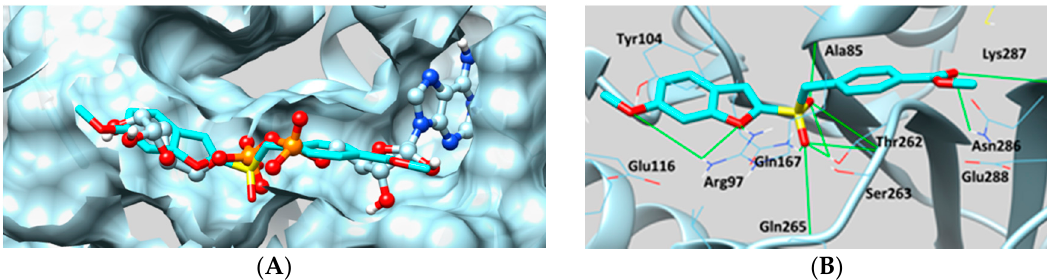
Figure 3. CDOCKER-modeled binding mode of compound 7e (carbon atoms colored aqua, oxygen atom colored red, sulfur atom colored yellow) with SIRT2 (3ZGV in PDB). ( A ) the binding pose of compound 7e within the binding site of the ADP-ribose (carbon atoms colored powderblue, nitrogen atom colored blue, phosphorus atom colored orange, oxygen atom colored red); ( B ) the interactions of compound 7e with key amino acids within the binding stie. H-Bonding interactions were presented with green lines.